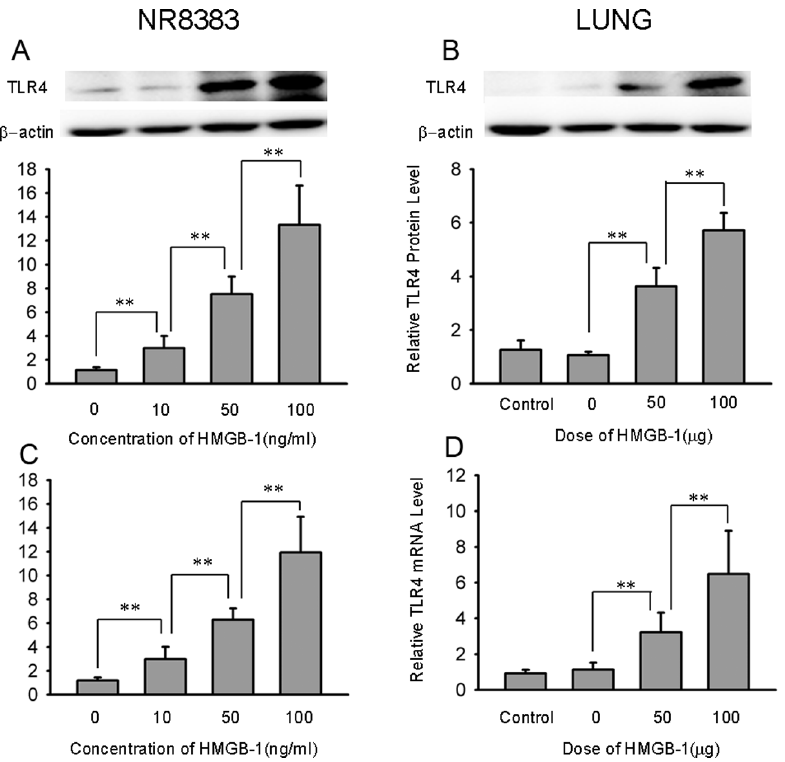
Figure 3. Expression of TLR4 after HMGB-1 treatment invitro and invivo . The expression of TLR4 was assessed by western blot analysis as well as real-time quantitative PCR analysis. For the in vitro studies, the expression of TLR4 protein and TLR4 mRNA levels were elevated after HMGB-1 stimulation, and every group displayed significant elevation (A, C). For the in vivo studies, the TLR4 protein and TLR4 mRNA levels in the 0 m g HMGB-1 treated group were comparatively equal to that of control. In addition, after HMGB-1 stimulation, the protein and mRNA levels were both clearly increased in a dose-dependent manner (B, D). Data are shown as the mean 6 SD, n=6, ** P , 0.01.